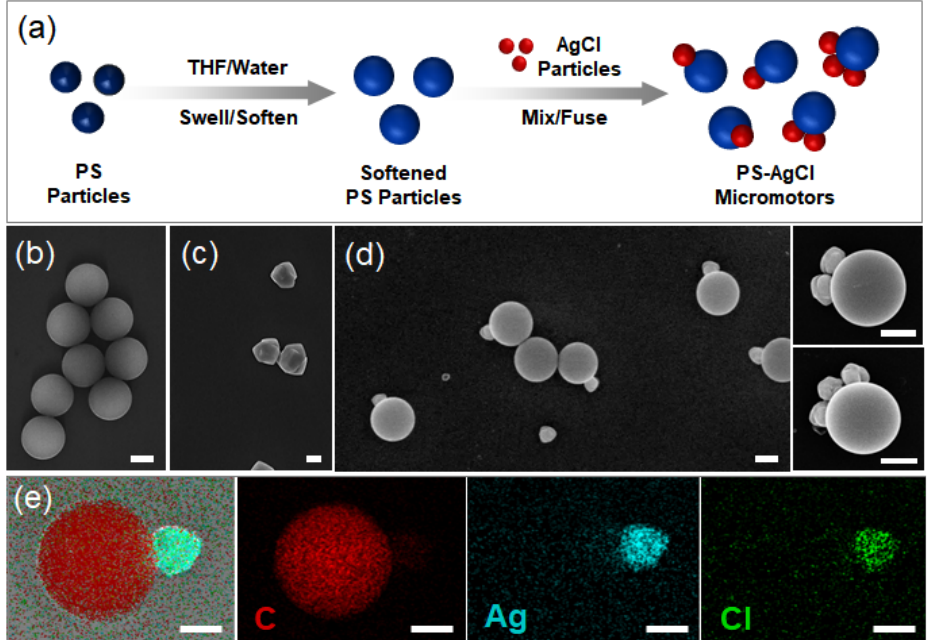
Figure 1. ( a ) Schematic of the synthesis procedure. PS particles (blue) are softened by tetrahydrofuran (THF) and then fused with inorganic particles, AgCl (red). ( b – d ) SEM images of PS particles, AgCl particles, and PS–AgCl hybrid dimer, trimer, and tetramer active colloids. ( e ) Energy-dispersive X-ray analysis of the C/Ag/Cl hybrid active colloids with an indication of the elemental composition. Scale bars: 500 nm.